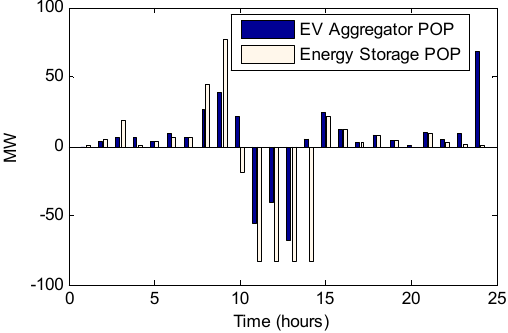
Figure 7. POP for the Electric Vehicle (EV) aggregator and dedicated storage unit.